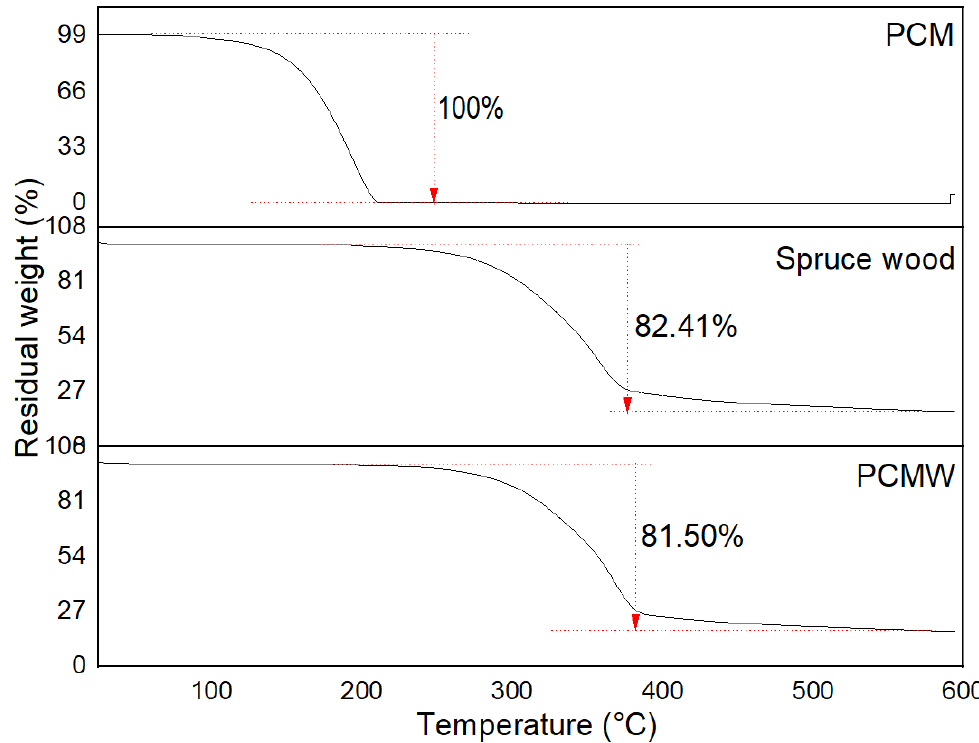
Figure 4. Residual weight of the PCM (n-HD)- and PCM-impregnated wood (PCMW).